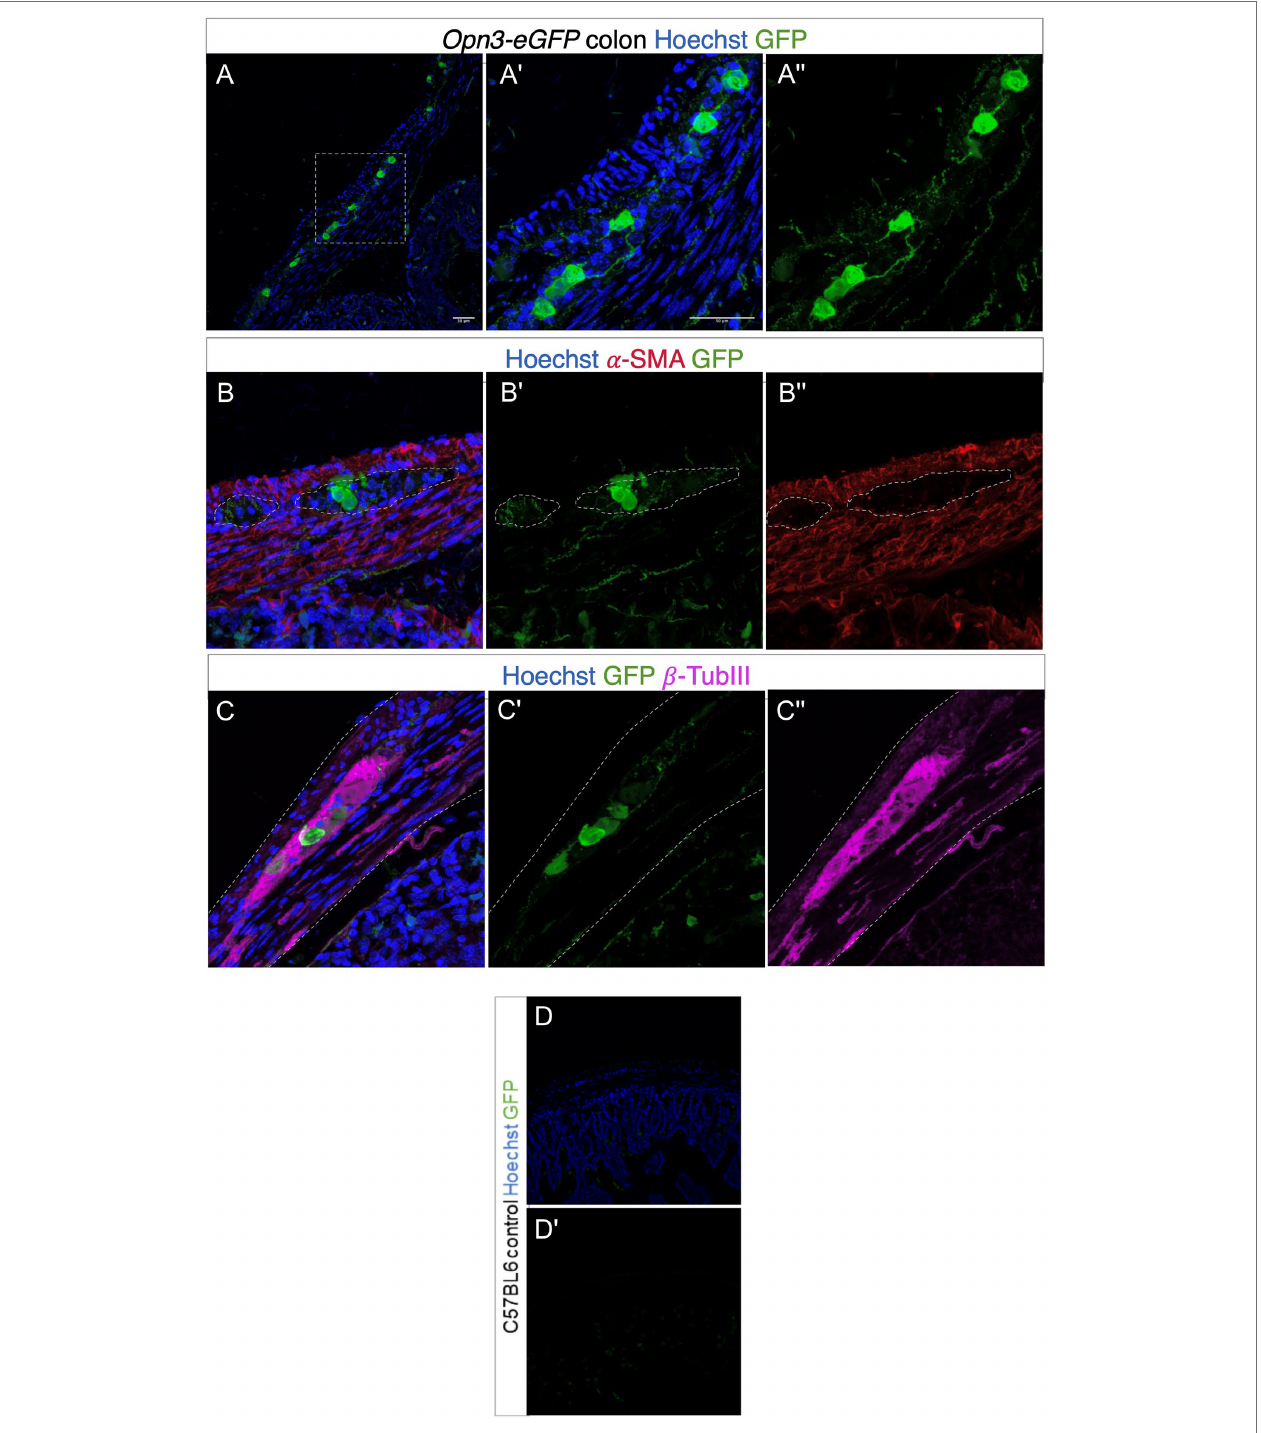
FIGURE 3 | Expression of Opsin 3 (Opn3)-eGFP in adult mouse proximal colon. (A–C) Opn3-eGFP expression in neurons within the myenteric plexus demonstrated by green fluorescent staining. Red fluorescent staining demonstrates positively labeled α -SMA. Violet fluorescent staining demonstrates positively labeled β -Tubulin III. Blue fluorescence indicates positive Hoechst nuclear staining. (A ' ,A '' ) Magnified images of area demarcated in (A) . (B,B ' ) Opn3-eGFP labeling shows discrete low-level expression inside the smooth muscle layer (labeled with α -SMA). (C,C ' ) Opn3- eGFP labeling is evident in neuronal cells (labeled with β -Tubulin III). Note GFP+ nerve fibers in (A,B) . Gray dashed lines in (B,C) indicate areas of interest. Lighter staining as well as discrete cellular areas in the smooth muscle layers is not specifically colocalized within SMA-positive cells, but is in the muscle layer appreciated in (A '' ) as well as (B ' ) . Bottom panel (control; D,D ' ) Proximal colon from C57BL6 animals that have no Opn3-eGFP expression. Note endogenous background fluorescence within crypts but none within the colon muscle/neuron